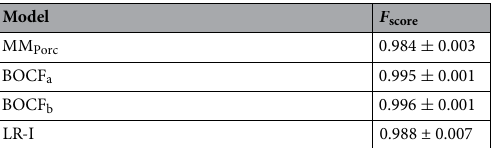
Table 1. Prediction of spiral wave tips. The F score is shown for the case where the UNet was trained with a single cell model, and the prediction was performed on the same